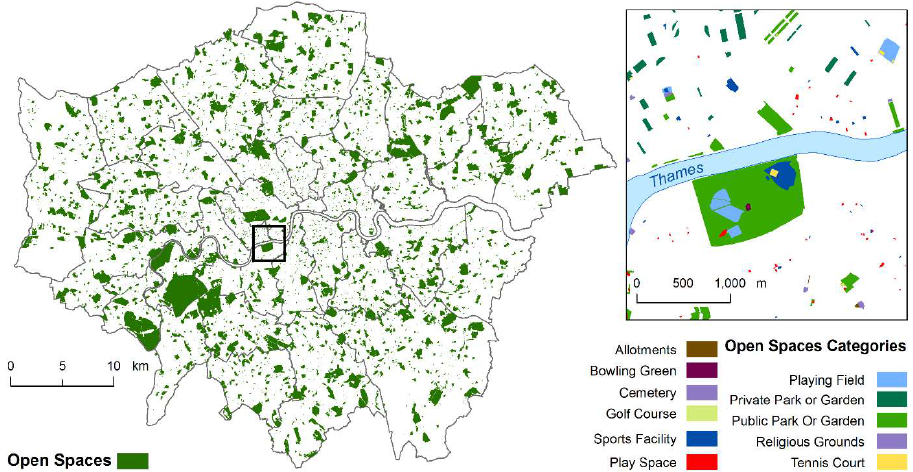
Figure 1. Open spaces in Greater London (within the extent of the 32 London Boroughs and the City of London) by category. [Contains OS Open Data © Crown copyright and database right 2019; OS licenced data © Crown copyright and database rights 2019 Ordnance Survey (100025252) and data provided by Greenspace Information for Greater London CIC, with permission to publish for illustrative purposes only, 2019].